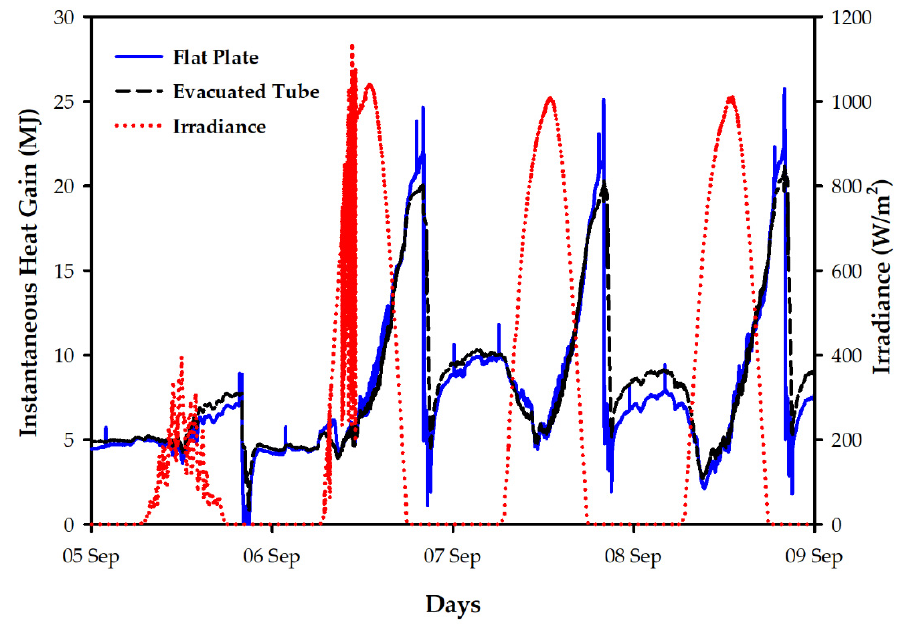
Figure 7. The heat gained by the flat plate and evacuated tube systems.